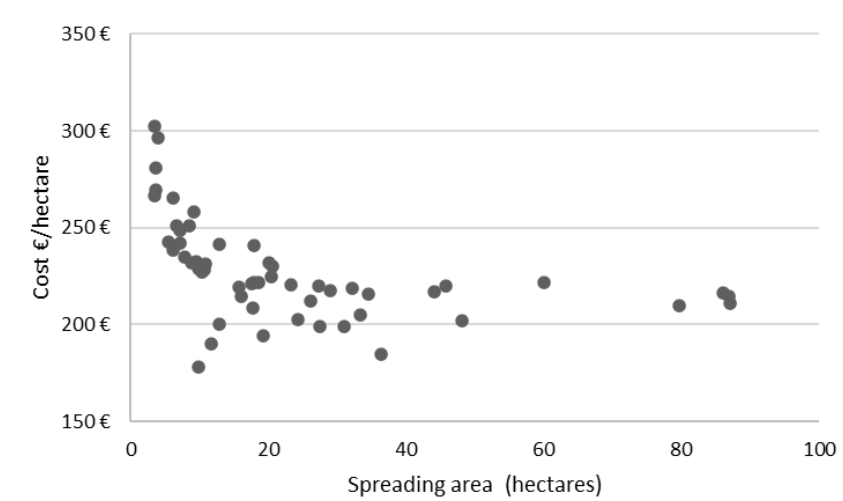
Fig. 3. Costs of gypsum amendment (euros/hectare) as a function of the area treated by gypsum per farm